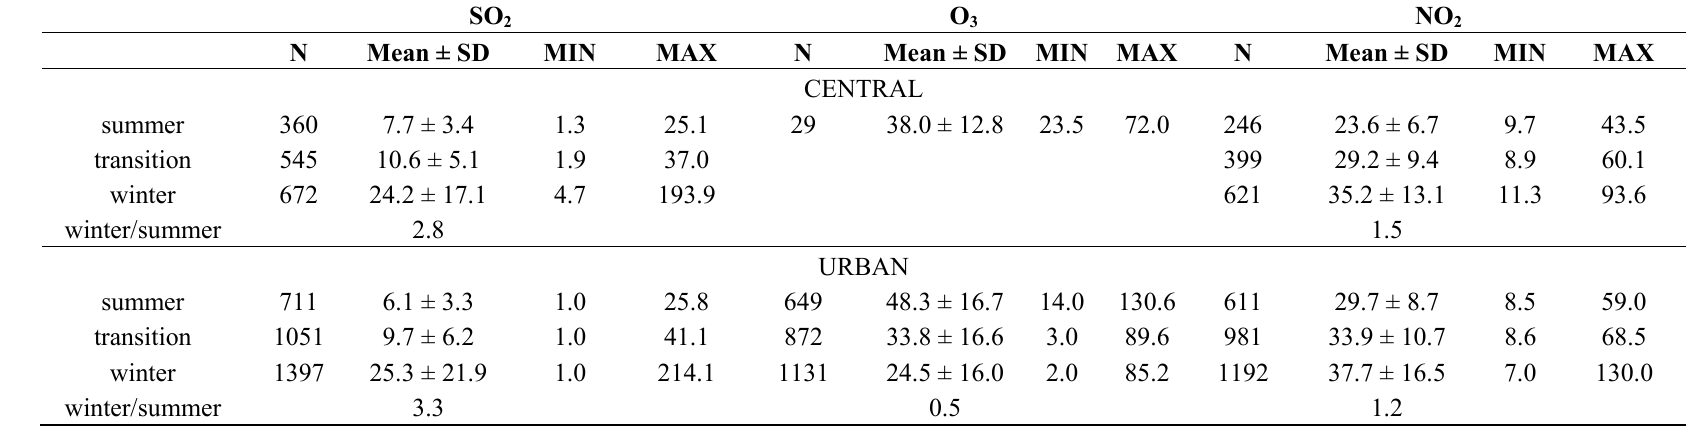
Table 4. Concentration distributions for SO 2 , O 3 , and NO 2 by site and season, 2000 